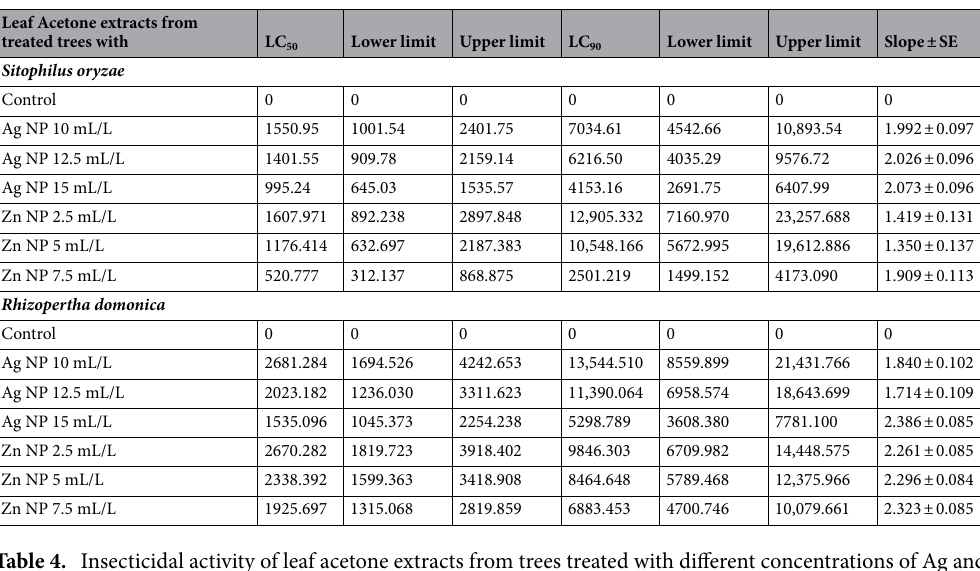
Table 4. Insecticidal activity of leaf acetone extracts from trees treated with different concentrations of Ag and Zn NPs against Sitophilus oryzae and Rhizopertha domonica.